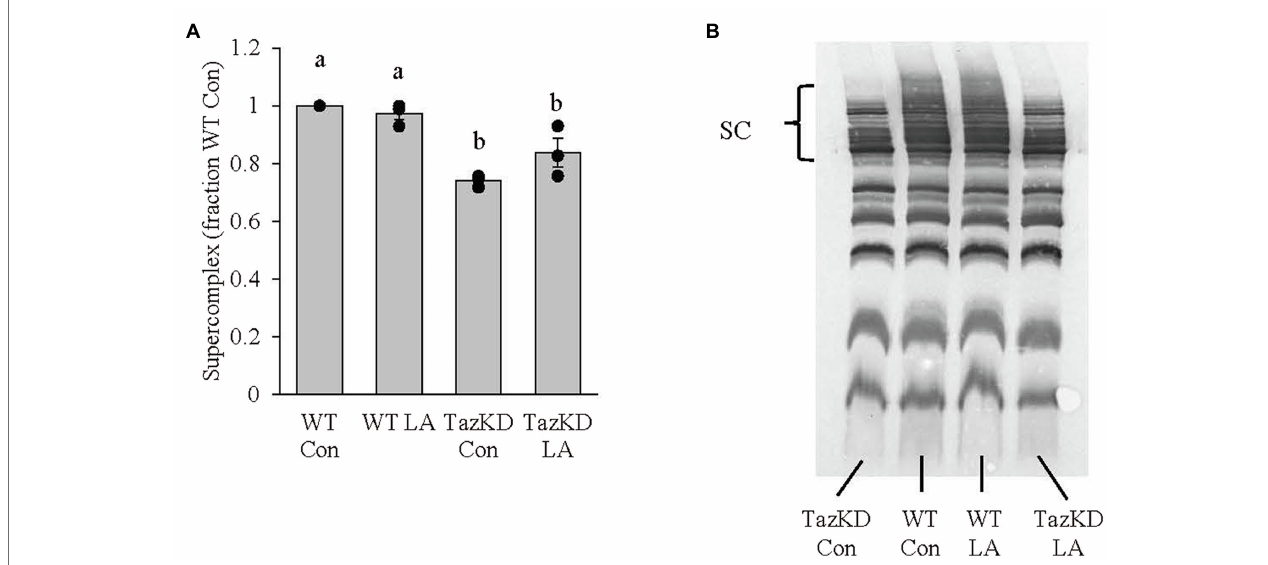
FIGURE 8 | Subsarcolemmal mitochondria isolated from whole hindlimb of TazKD male mice demonstrated (A) lower supercomplex formation compared to wild- type littermates, which was not significantly increased ( p = 0.14) with 8 weeks of supplemental linoleic acid diet. (B) Example membrane from blue-native polyacrylamide gel electrophoresis. Values are means ± SEM, n = 3. WT, wild type; TazKD, tafazzin knockdown; Con, chow diet; LA, linoleic acid-supplemented diet; and SC,